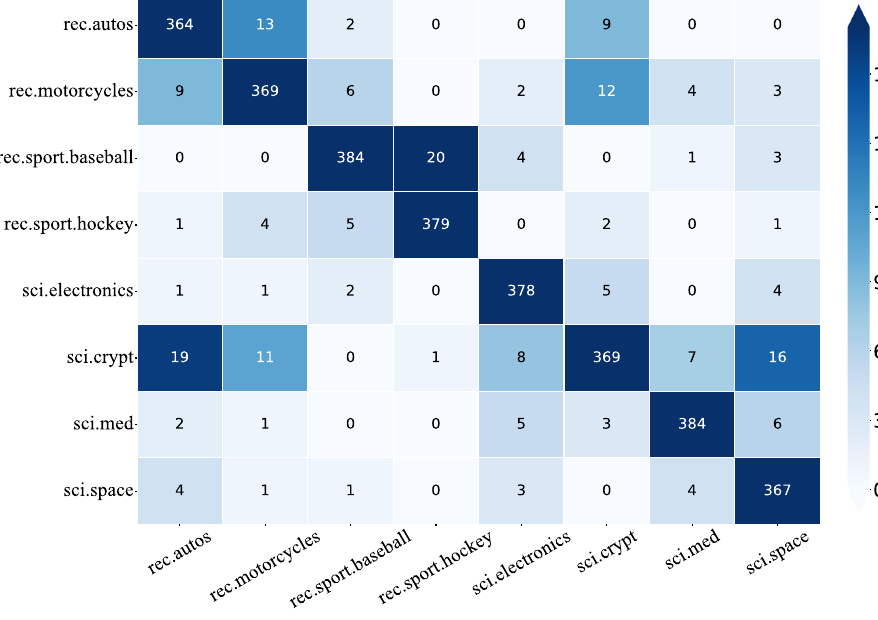
Fig. 16 Testing with conceptual